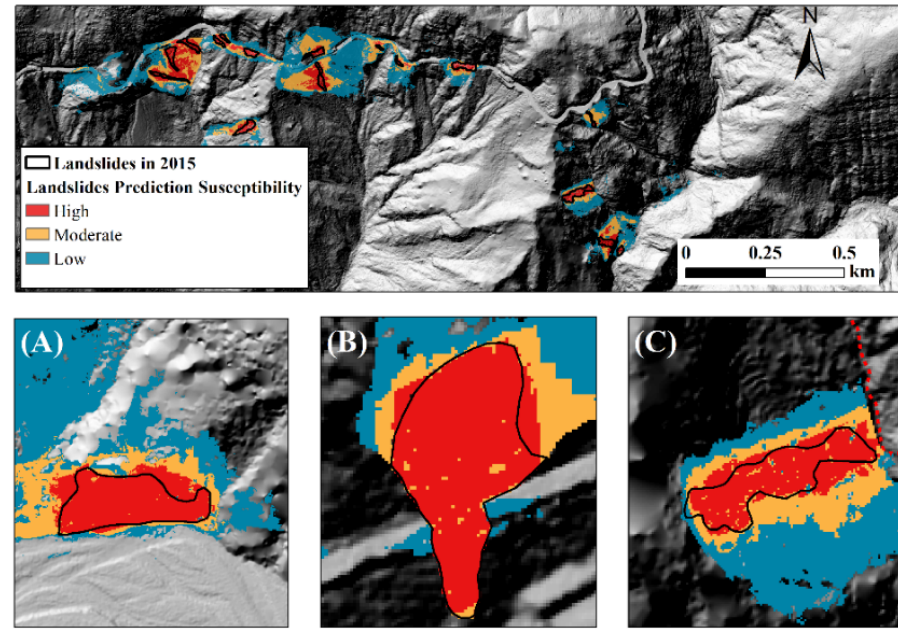
Figure 5. A high-density landside region and three enlarged sites A, B, and C of predicted landsides along the Alishan highway, overlaid with the ground reference landslides in 2015.